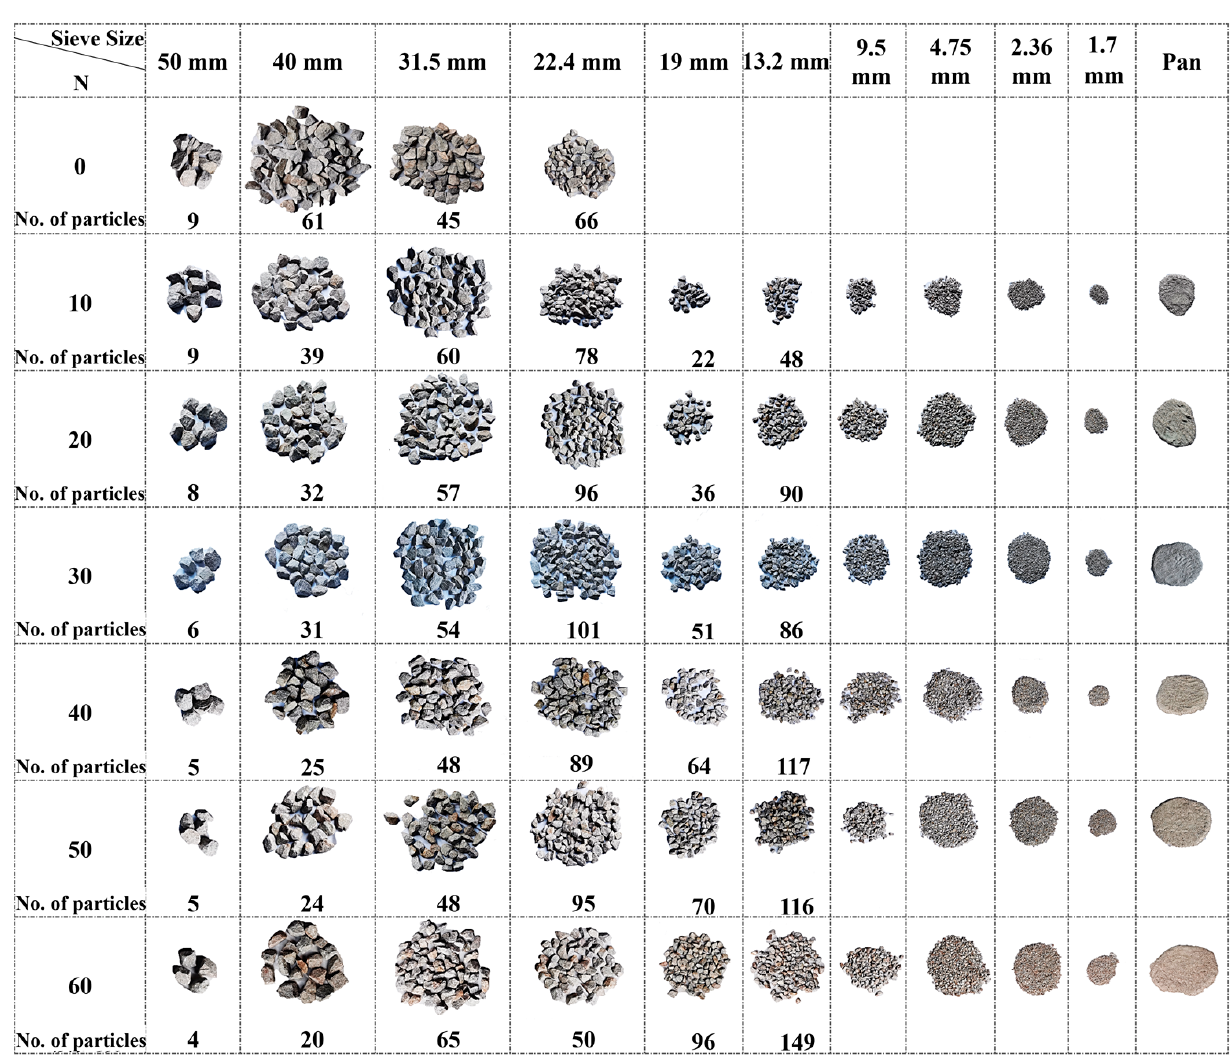
Figure 12. Photos of particle-size-degradation trends of regularly shaped multiple-size ballasts upon the completion of every 10 impact-load applications under the combination of a rigid concrete block support and an 80 cm drop height.